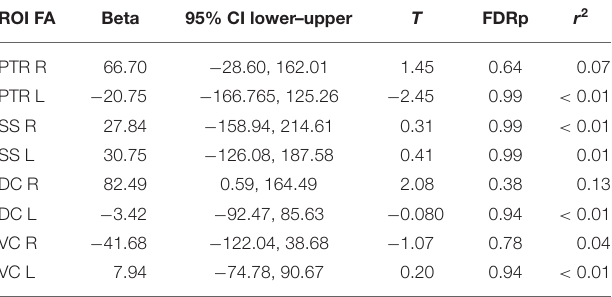
TABLE 3 | Linear regression results for change in mean FA with change in Y-BOCS in the OCD patients ( n = 26). ROI FA Beta 95% CI lower–upper